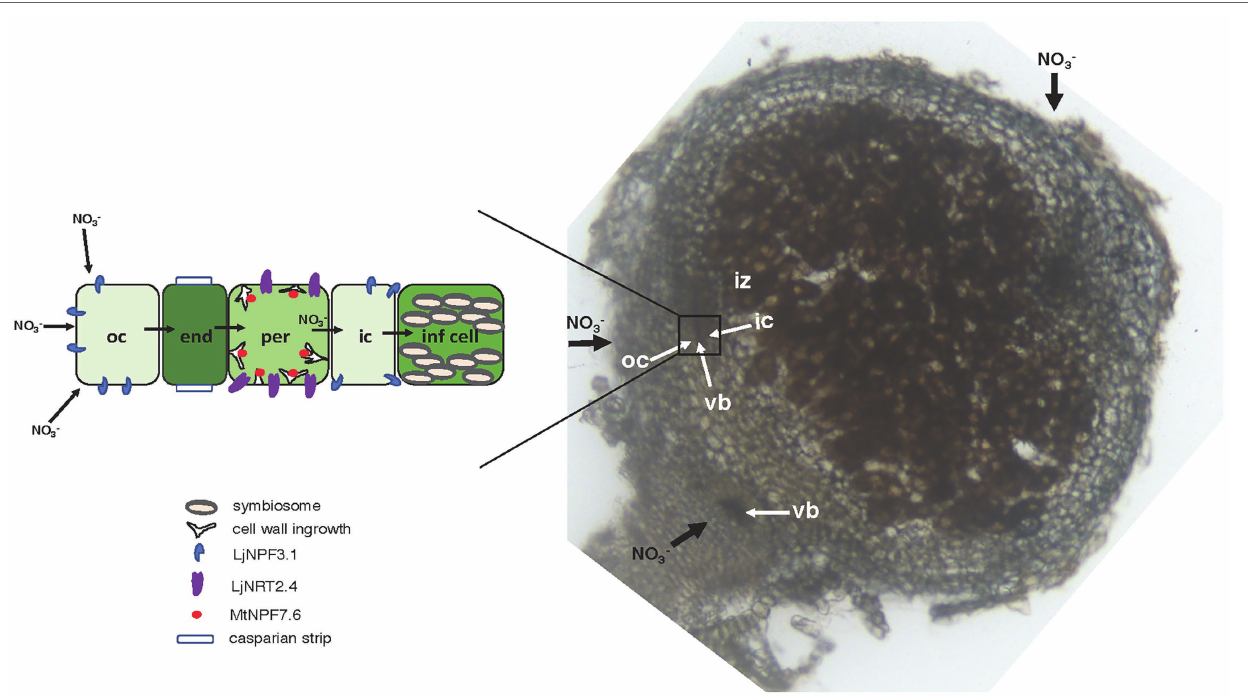
FIGURE 7 | Model of nitrate flux in the N 2 -fixing nodule. Right side: 70 μ m vibratome longitudinal section of a 4-week old L. japonicus nodule with an illustration of the flux of nitrate (thick black arrows) toward the infected cells of the N 2 -fixation zone either from the root or from outside to inside the nodule. The rectangle indicates the vascular bundle structure bracketed by the outer and inner cortex. Left side: scheme of the flux of nitrate through different cell layers with an illustration of the NPFs and NRT2 involved. The NPFs and NRT2 transporters involved in the transport of nitrate, subcellular structures, and organelles are indicated. oc, outer cortex; ic, inner cortex; vb, vascular bundle; iz, infection zone; end, endodermis; per, pericycle; inf cell, infected